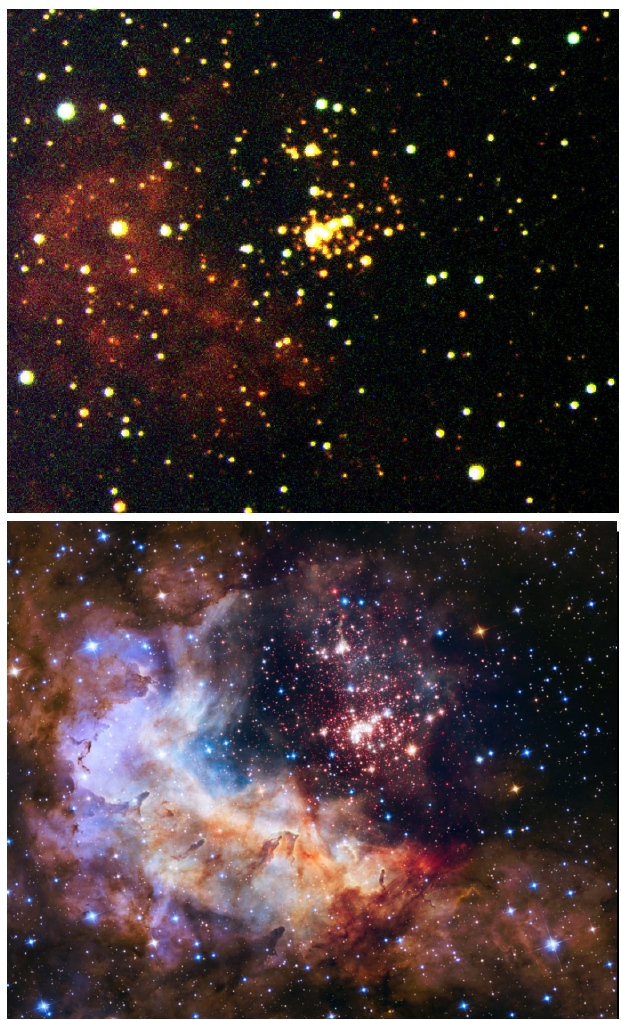
Fig. 3.— Two images of Westerlund 2. Image credit top: 2 m Faulkes Telescope operated by Las Cumbres Observatory at Siding Spring under license CC BY-2.0. Bottom image: NASA, ESA, the Hubble Heritage Team (STScI/AURA), A. Nota (ESA/STScI), and the Westerlund 2 Science